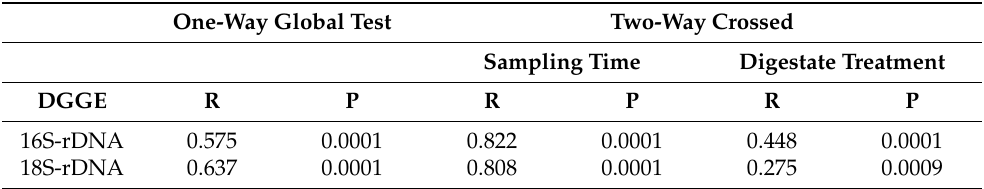
Table 7. Summary of ANOSIM analysis based on 16S- and 18S-rDNA Dice similarity matrices. In the one-way ANOSIM groups were analysed independently (three digestate treatments vs. four sampling time), whereas the two factors (sampling time and digestate treatments) were analysed by a two-way analysis. One-Way Global Test Two-Way Crossed Sampling